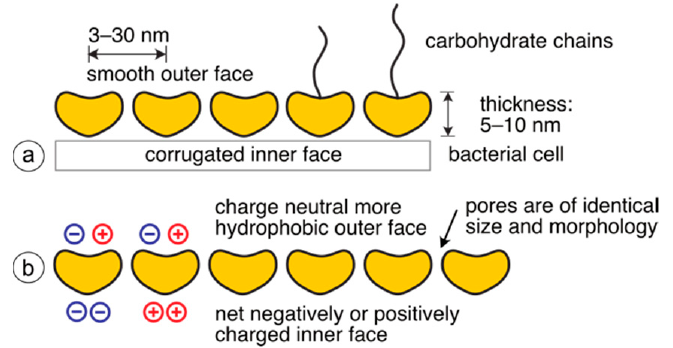
Figure 2. Schematic drawings of the ( a ) topographical and ( b ) physicochemical surface properties of S-layers from Bacillaceae .